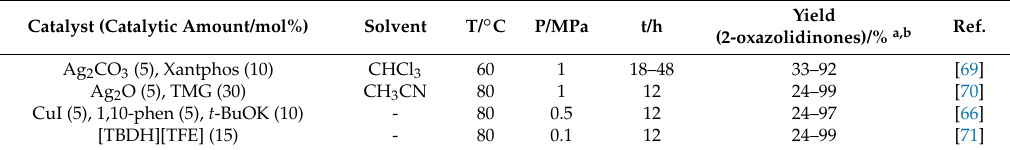
Yield (2-oxazolidinones)/%